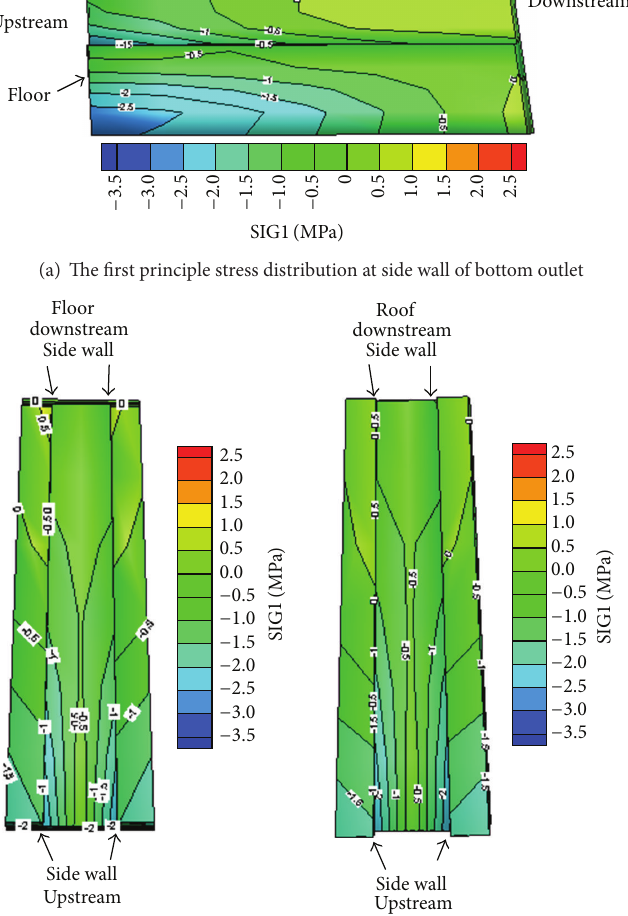
Figure 10: The first/third principle stress distribution of bottom outlets under analysis case